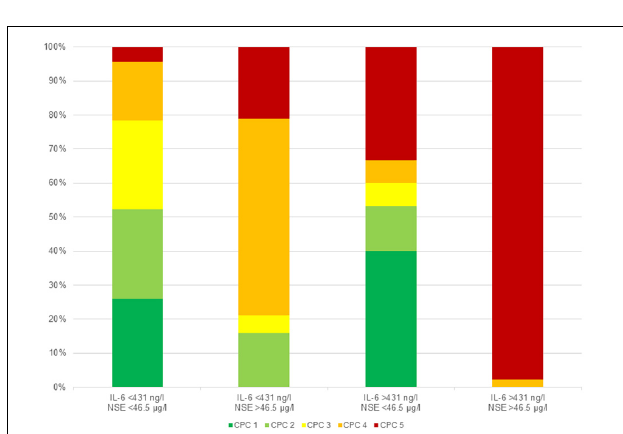
FIGURE 5 | Neurological outcome according to CPC class in the corresponding groups depending to the determined cut-off values for mortality without patients dying during the first 3